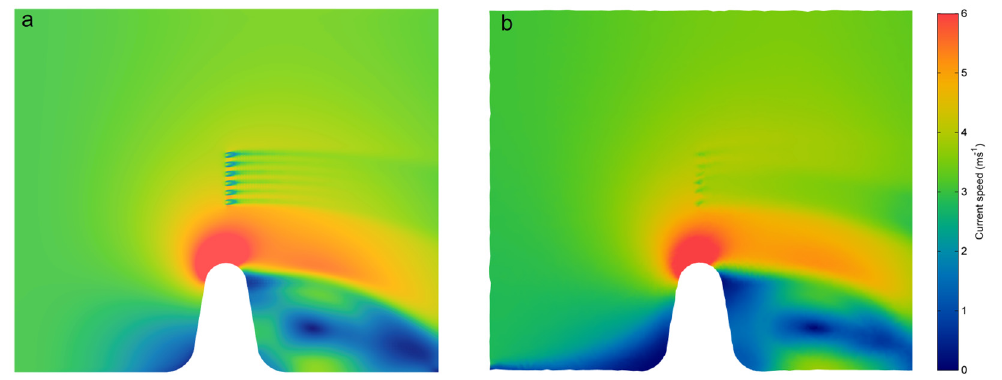
Figure 9. Horizontal flow fields for the headland fence case: The images show velocity magnitude at hub height from: ( a ) the BEM-CFD model; and ( b ) the coastal area model. Flow is from left to right in the